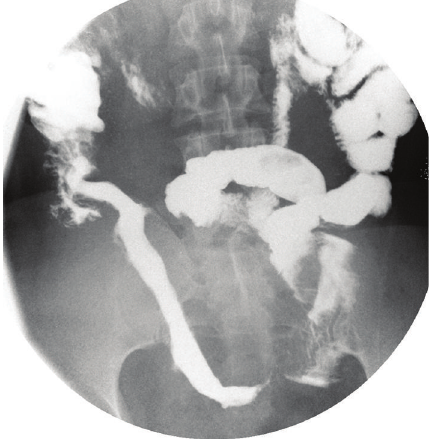
Figure 3: Barium small bowel passage radiogram displaying marked wall thickening involving a 40 cm long segment adjacent to the terminal ileum, characterized by displacement of the adjacent intestinal loops. No luminal irregularity, narrowing, or cavity for- mation was observed. These findings were interpreted as terminal ileal involvement of Crohn’s